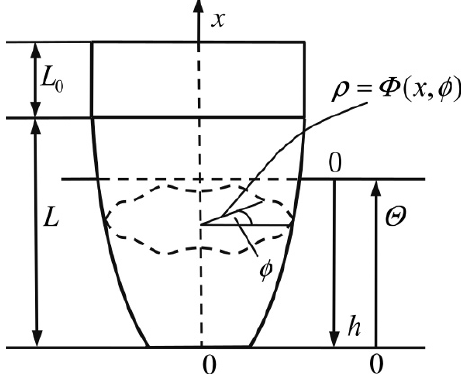
Figure 1. The notations.